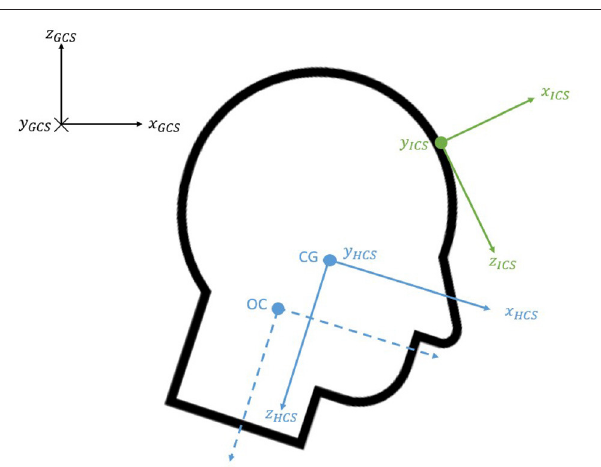
FIGURE 4 | Free body diagram of the